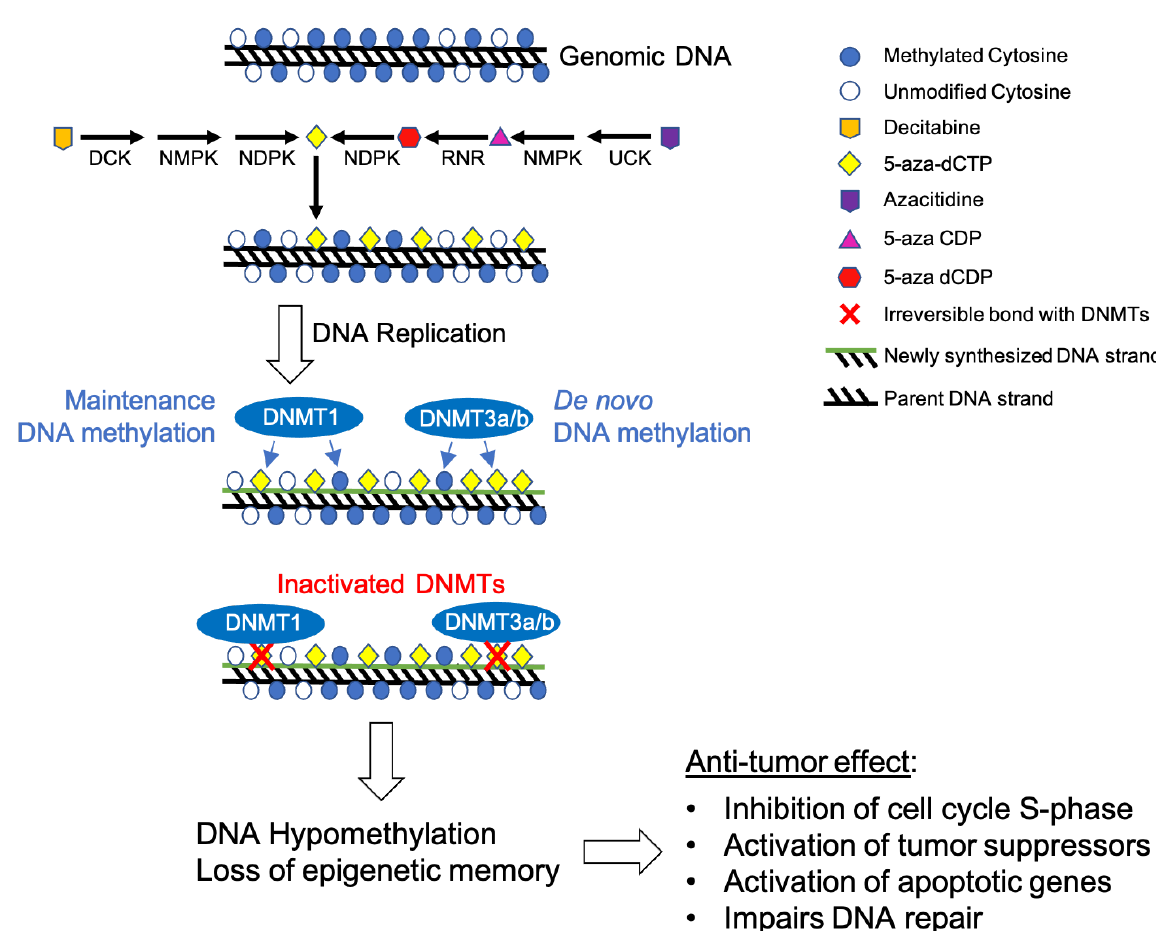
Figure 2. Inhibition of DNMTs upon incorporation of decitabine and azacytidine into DNA. The genomic DNA methylation landscape consists of methylated and unmethylated cytosines. Upon multiple phosphorylation steps by DCK (deoxycytidine kinase), NMPK (nucleoside monophosphate kinases) and NDPK (nucleoside diphosphatase kinase), decitabine becomes 5-aza-dCTP, which gets incorporated into DNA. Upon phosphorylation steps by UCK (uridine cytidine kinase) and NMPK (nucleoside monophosphate kinases), azacytidine is converted into 5-aza-CDP, which is recognized by ribonucleotide reductase (RNR) leading to the formation of 5-aza-dCDP. This reactive analog is further phosphorylated to 5-aza-dCTP by NDPK (nucleoside diphosphatase kinase), which is then integrated into genomic DNA. Upon DNA replication, DNMT1 maintains the methylation status of the genome. However, DNMT1 becomes covalently bound to the cytosine analog, 5-aza-dCTP, which prevents DNMT1 activity leading to genomic hypomethylation and loss of epigenetic memory. Additionally, other DNMT enzymes, DNMT3a and DNMT3b, can also form an irreversible interaction with azanucleosides leading to hypomethylation of the genome. Collectively, this drug-mediated DNA hypomethylation causes anti-tumorigenic effects including inhibition of the cell cycle, DNA repair impairments, activation of pro-apoptotic and tumor suppressor